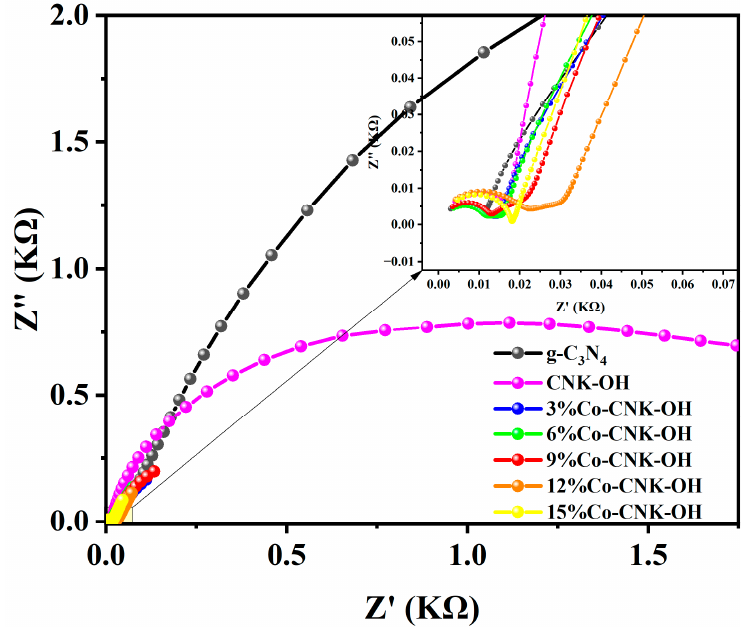
Figure 8. EIS of g-C 3 N 4 , CNK-OH, and Co-CNK-OH (outer fi gure) and enlarged view of 0.00-0.07 K Ω (sub- fi gure).